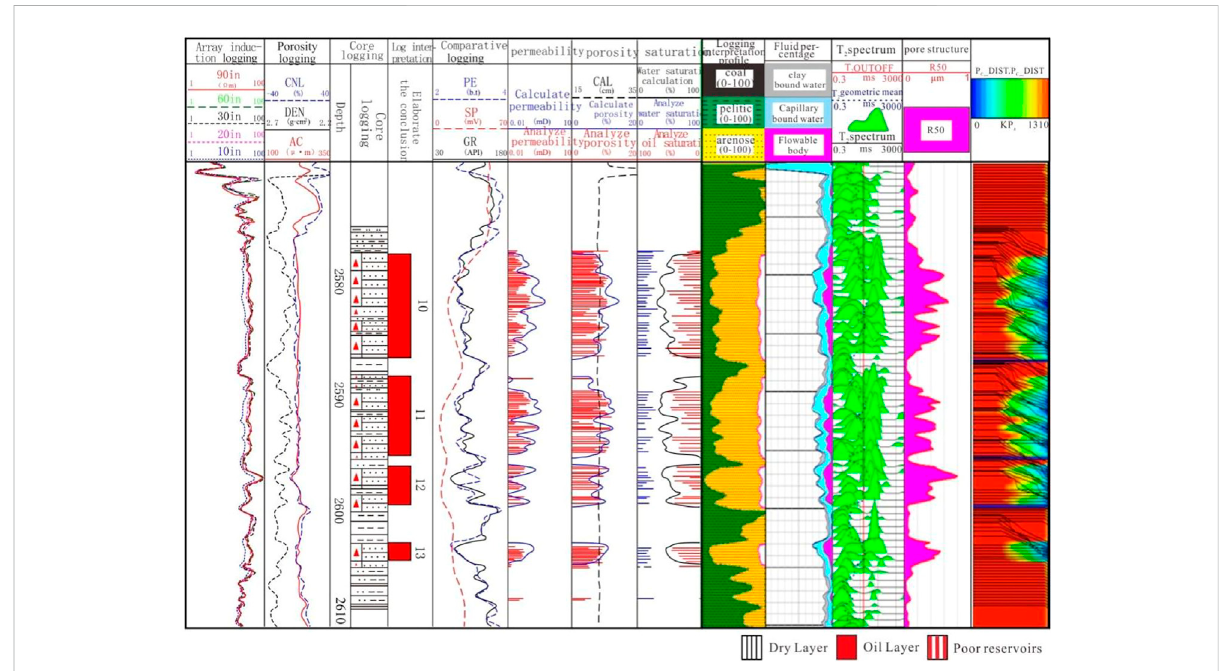
FIGURE 7 Interpretation results of pore structures from nuclear magnetic logging in the target layer of Well